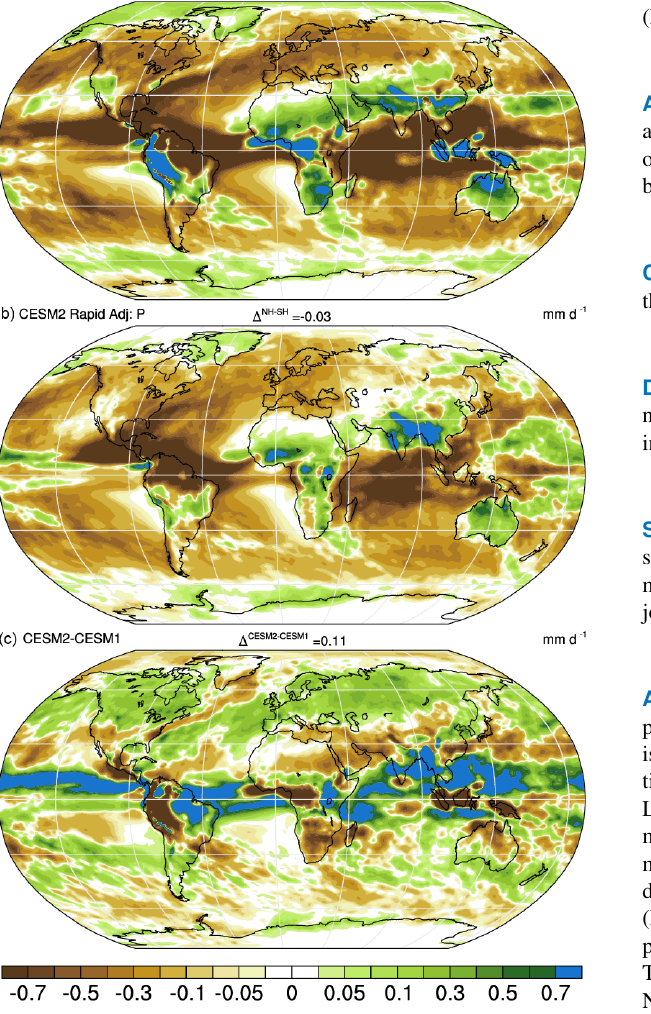
Figure A8. Rapid adjustments of precipitation (mmd − 1 ) to CO 2 based on 4 × AMIP–AMIP simulation differences in (a) CESM1, (b) CESM2, and (c) their difference ( a minus b